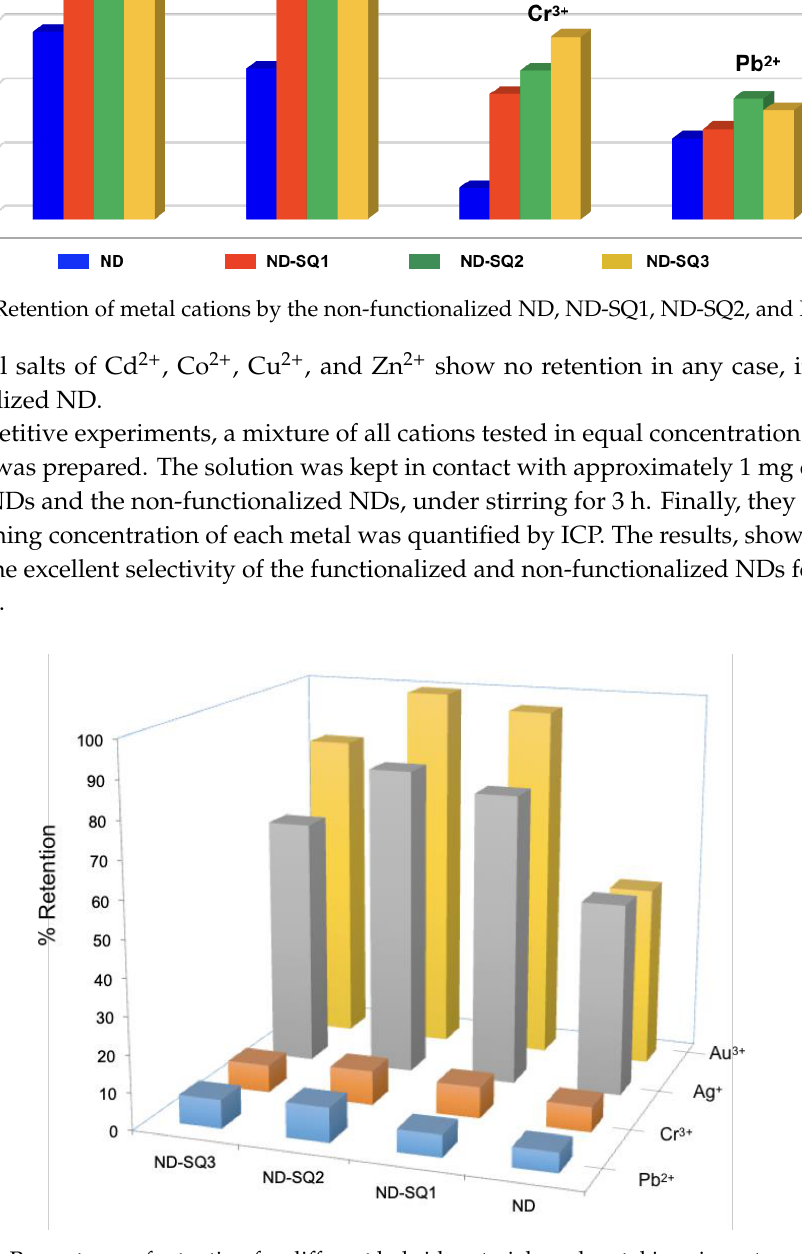
Figure 8. Percentages of retention for di ff erent hybrid materials and metal ions in water solution.